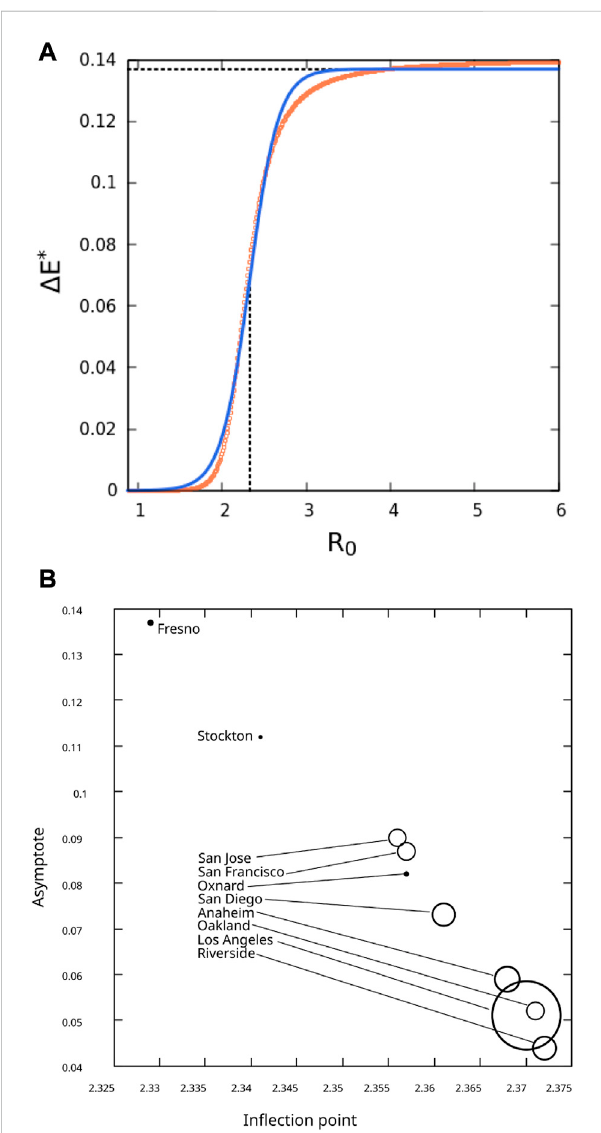
FIGURE 4 (A) Cascade magnitude (red dots), or the difference between disease-driven and economic cascade reductions of employment, on day 151, at values of R 0 ranging from 0.9 to 4.0, for the Fresno SES. Solid blue line is a fi tted logistic function. The horizontal dotted line is the asymptotic value of the function. The vertical dotted line is the point of maximum increase of the function (in fl ection point), showing the corresponding value of R 0 . (B) In fl ections points and asymptotic values for all SESs, showing that SESs with lower in fl ection points, that is, critical values of R 0 , also experience greater reductions of employment. Symbol size scaled to number of workers per SES.